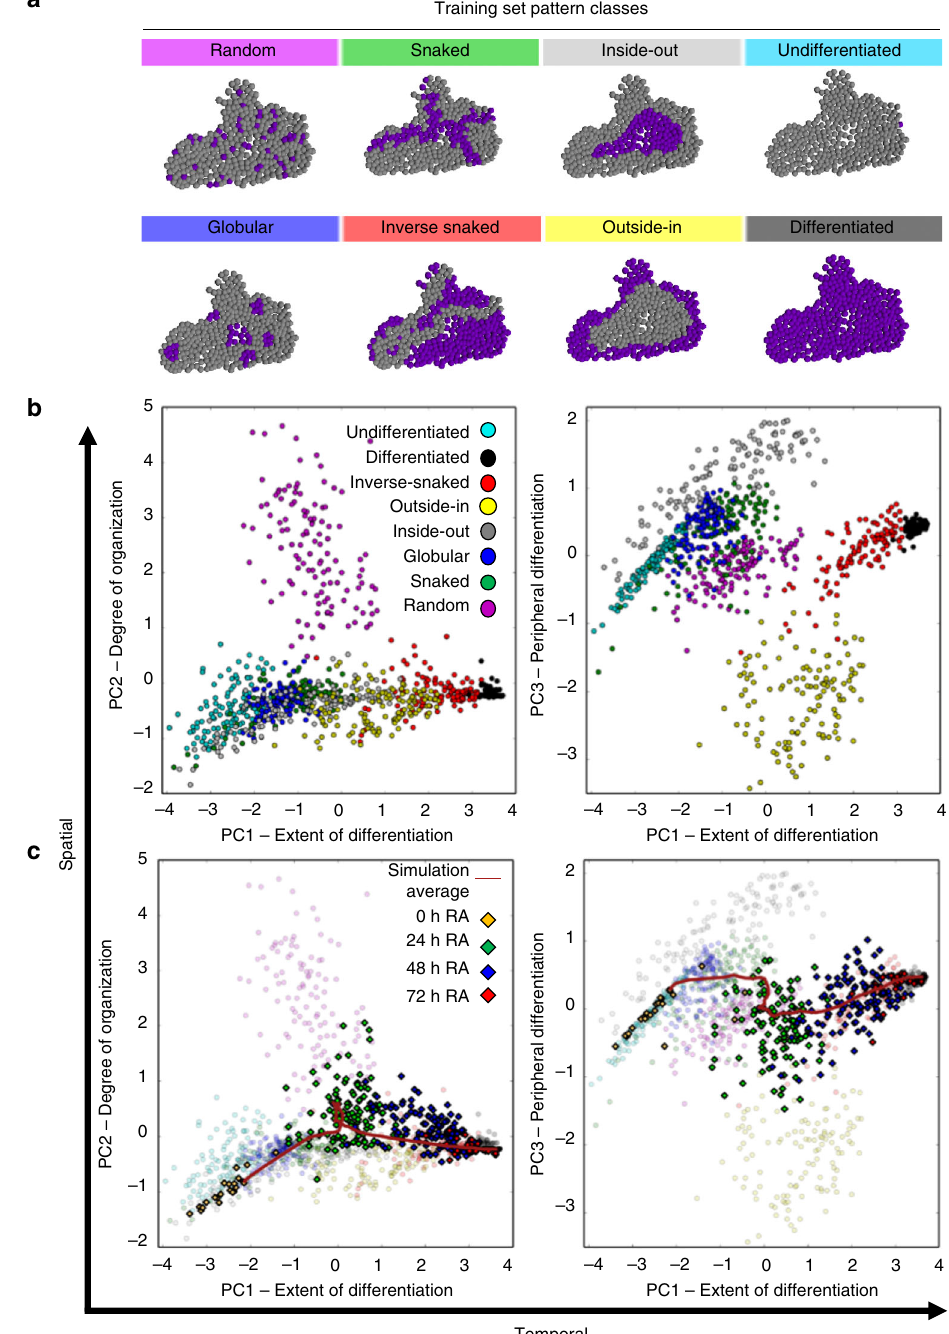
Fig. 5 Quanti fi cation of spatial patterning during RA differentiation. a The computationally generated pattern class structures used to train the principle component analysis, derived from 33 , were applied to 120 experimental colony structures. b The seven selected metrics were calculated from each of the training set pattern classes (8 classes x 120 colony structures) and transformed into latent variable space through principal component analysis. PC1 represents extent of differentiation (temporal), and PC2 and PC3 represent organization/stochasticity and spatial locale, respectively (spatial characteristics). c The same metrics were calculated from experimental images of 0- ( n = 24), 24- ( n = 113), 48- ( n = 139), and 72-h ( n = 22) RA-treated colonies and transformed into latent variable space. The average simulation trajectory was capable of capturing the spatiotemporal trajectory of the experimental data (see Supplementary Figure 7 for simulation data points). At 24 h there is a steep transition along both spatial axes, indicating that there is a gain in random differentiation and that it propagates along the edges of colonies. By 48 h, the majority of differentiated cells are connected within